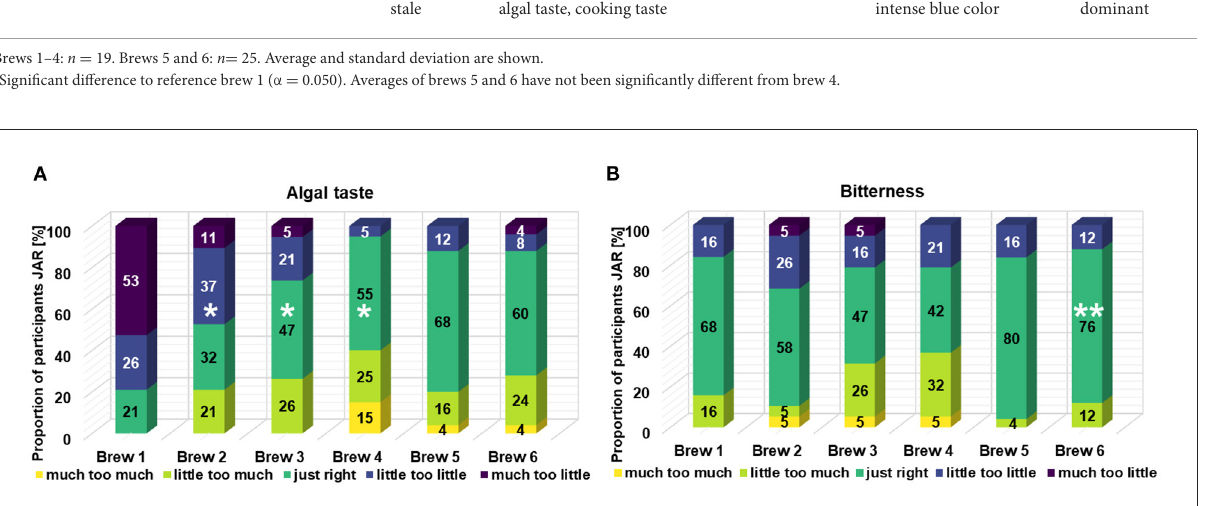
FIGURE4 Just-About-Right (JAR) frequencies for all brews for the attributes algal taste (A) and bitterness (B) . Brews 1–4: n = 19. Brews 5 and 6: n = 25. *Significant difference of averages to reference brew 1 ( α = 0.050). **Significant difference of averages to reference brew 4 ( α =